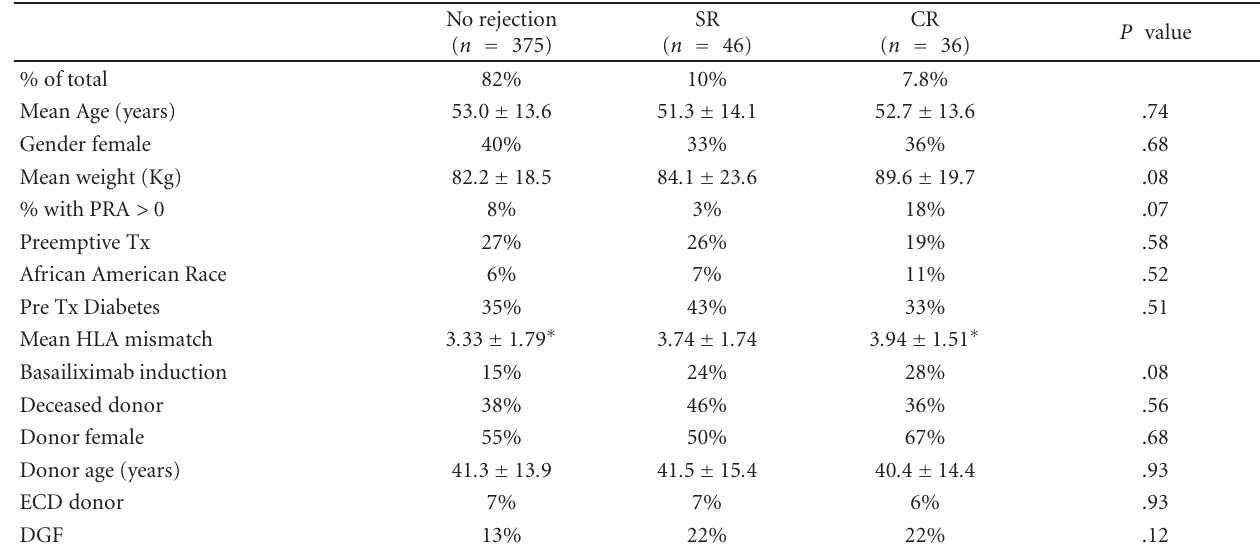
Table 1: Baseline patient and transplant characteristics.